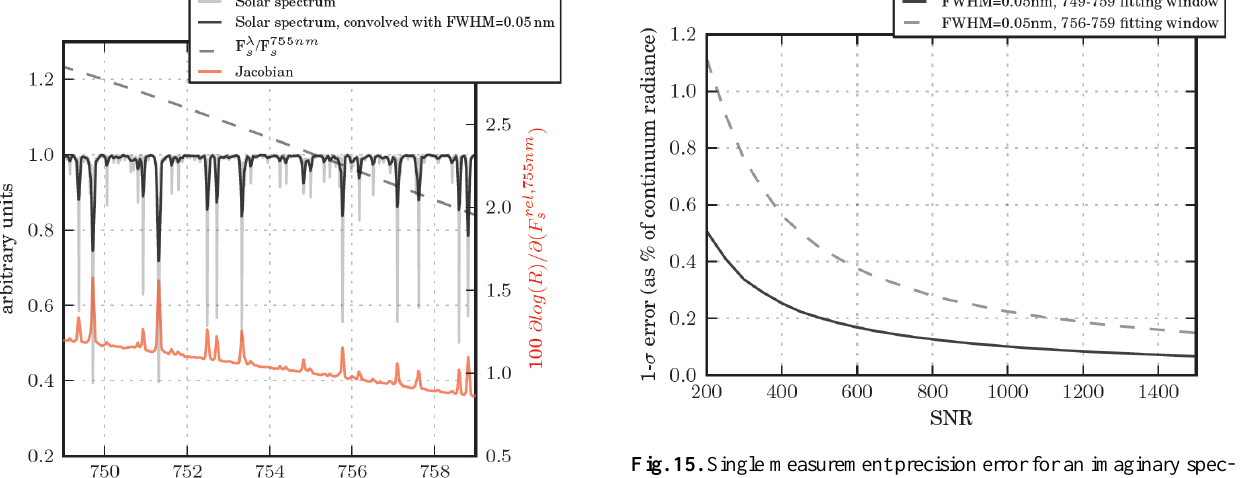
Fig. 15. Single measurement precision error for an imaginary spec- trometer with 0.05nm FWHM spectral resolution, varying signal- to-noise ratio (SNR) and spectra fitting windows for